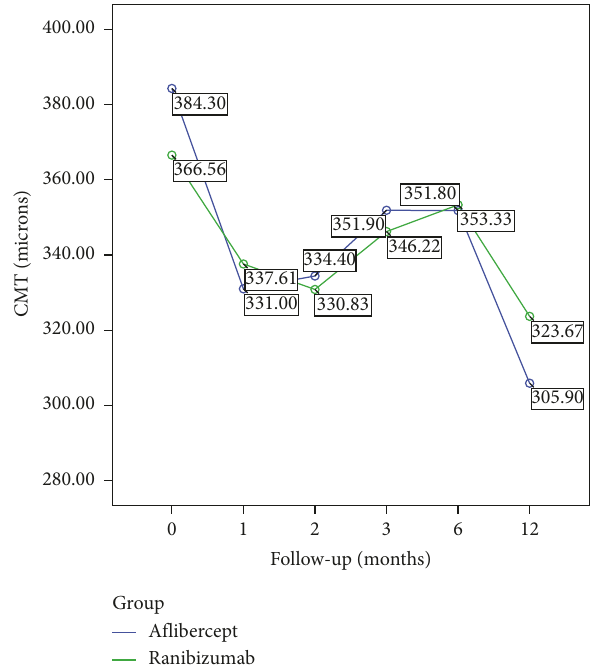
Figure 1: The mean BCVA increased in the IVA group significantly even at Month 2 ( p � 0 . 04) and the visual improvement continued till the final visit ( p � 0 . 024). The IVR group, however, maintained basically its baseline BCVA levels throughout the study period ( p � 0 . 345).